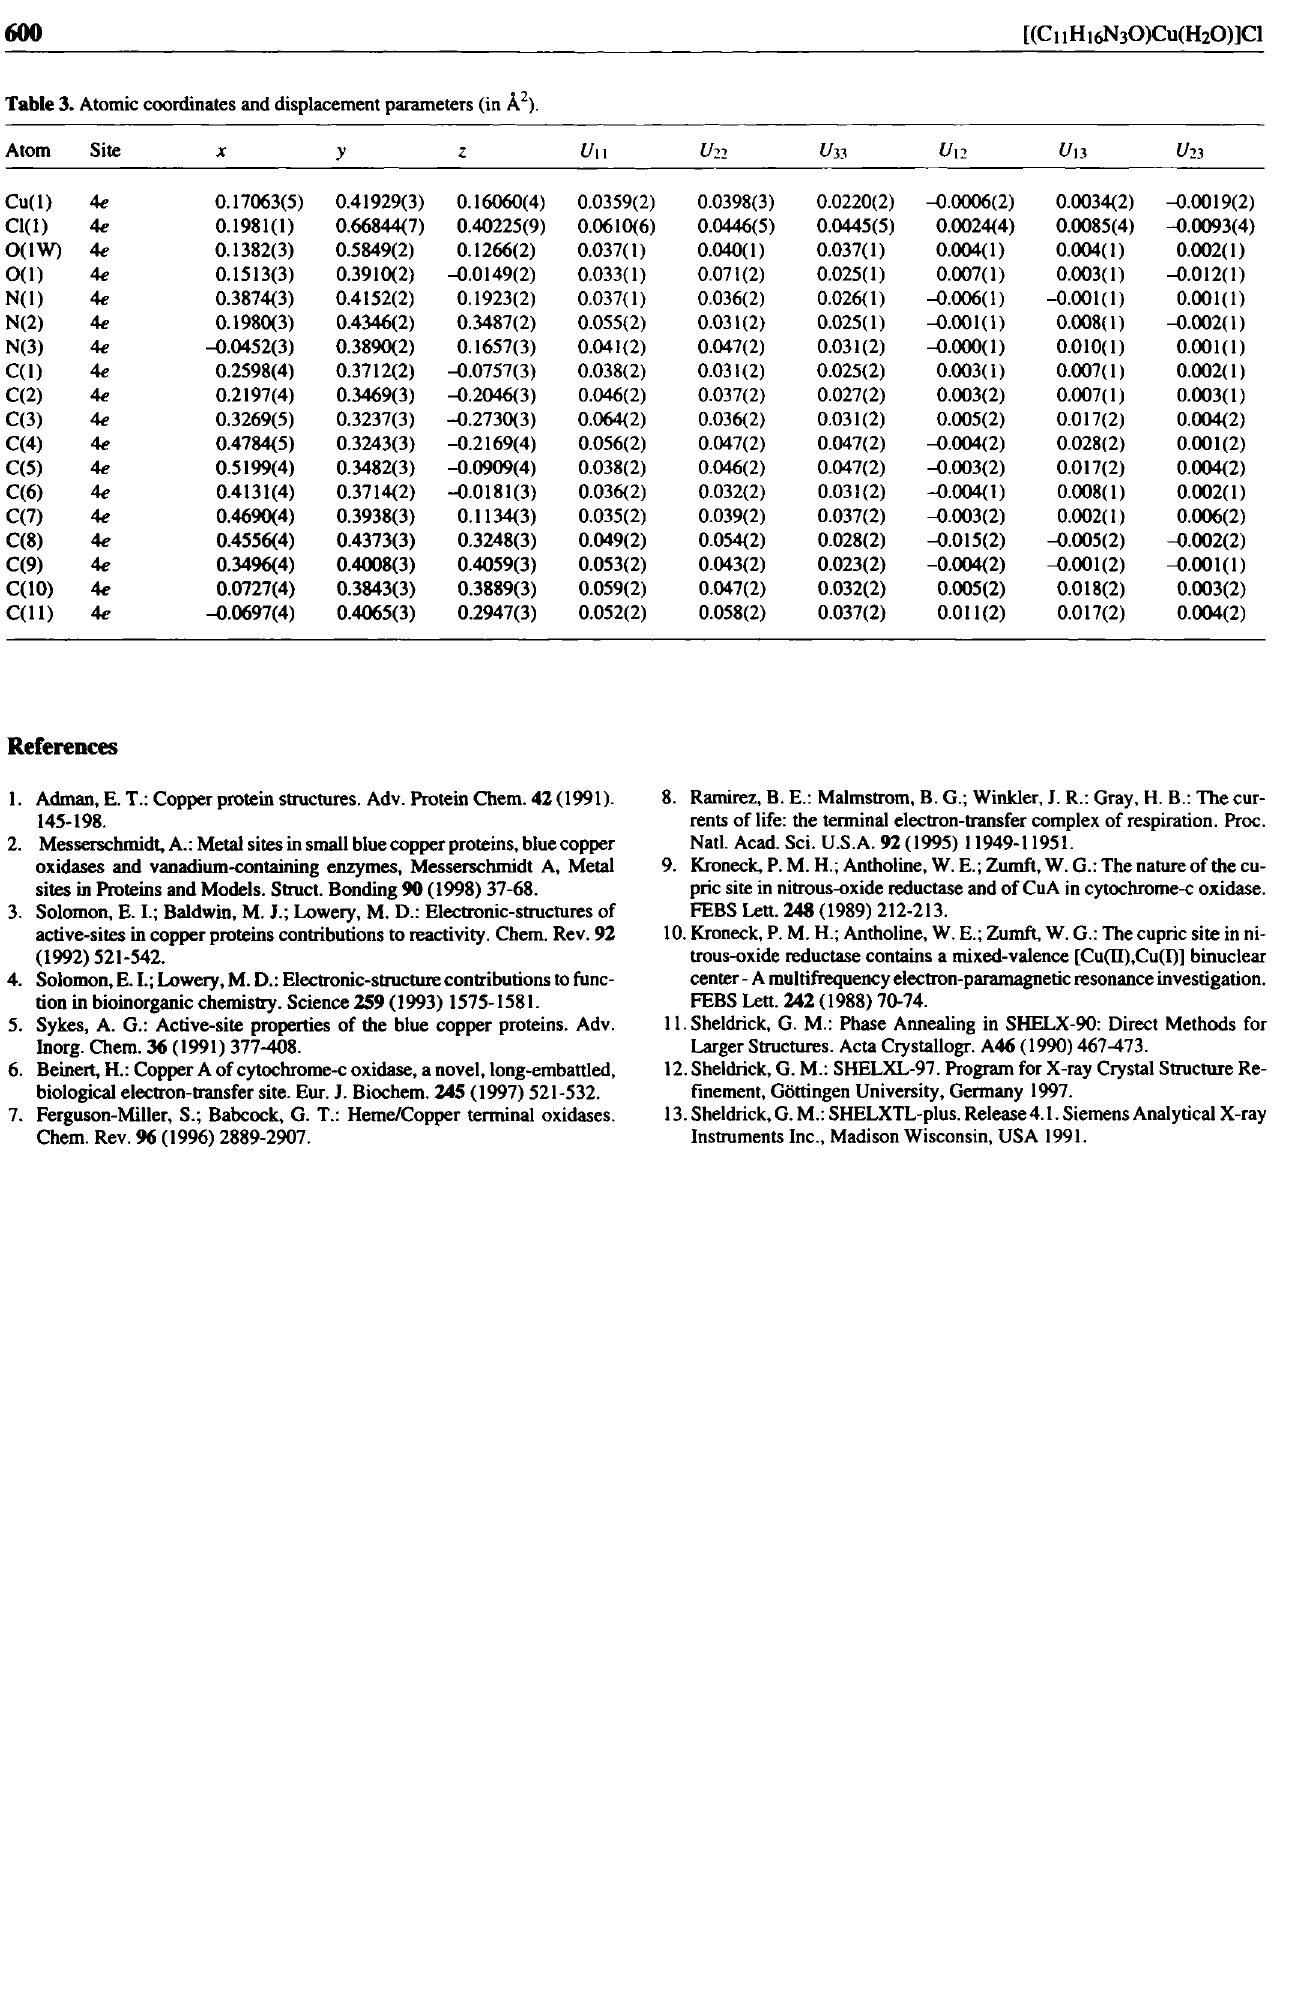
Table 3. Atomic coordinates and displacement parameters (in Â 2